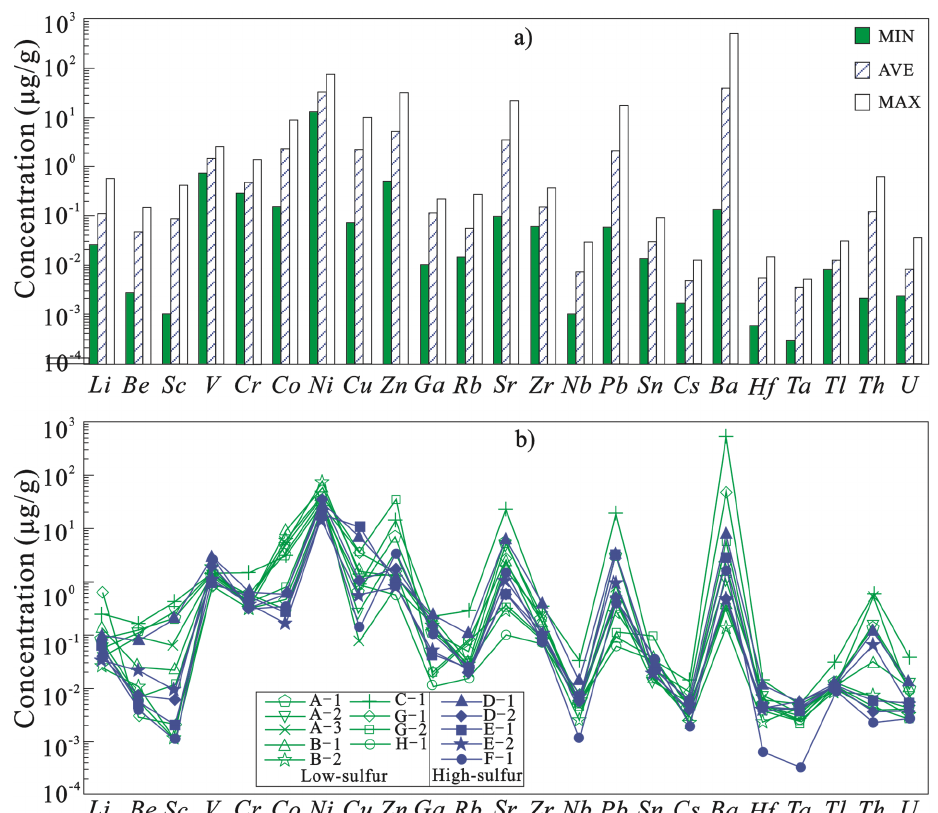
Figure 5. Concentrations ( a ) and distribution patterns ( b ) of trace elements in the studied oil samples. Table 3. Ratios of major and trace elements in the studied oil samples.